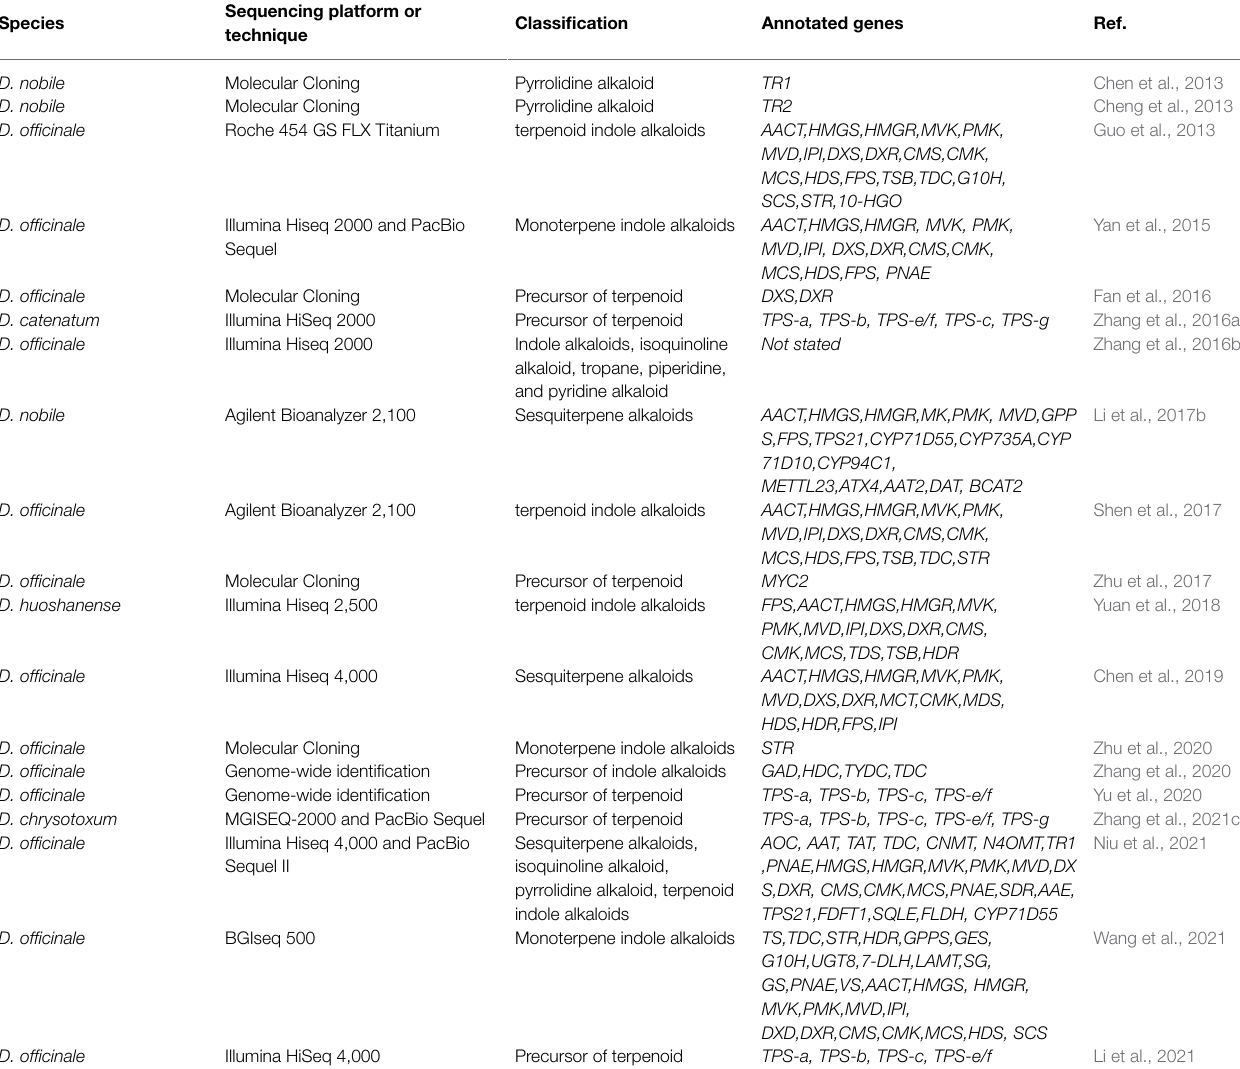
TABLE 2 | Identification of alkaloid-related compounds and key genes in Dendrobium spp.